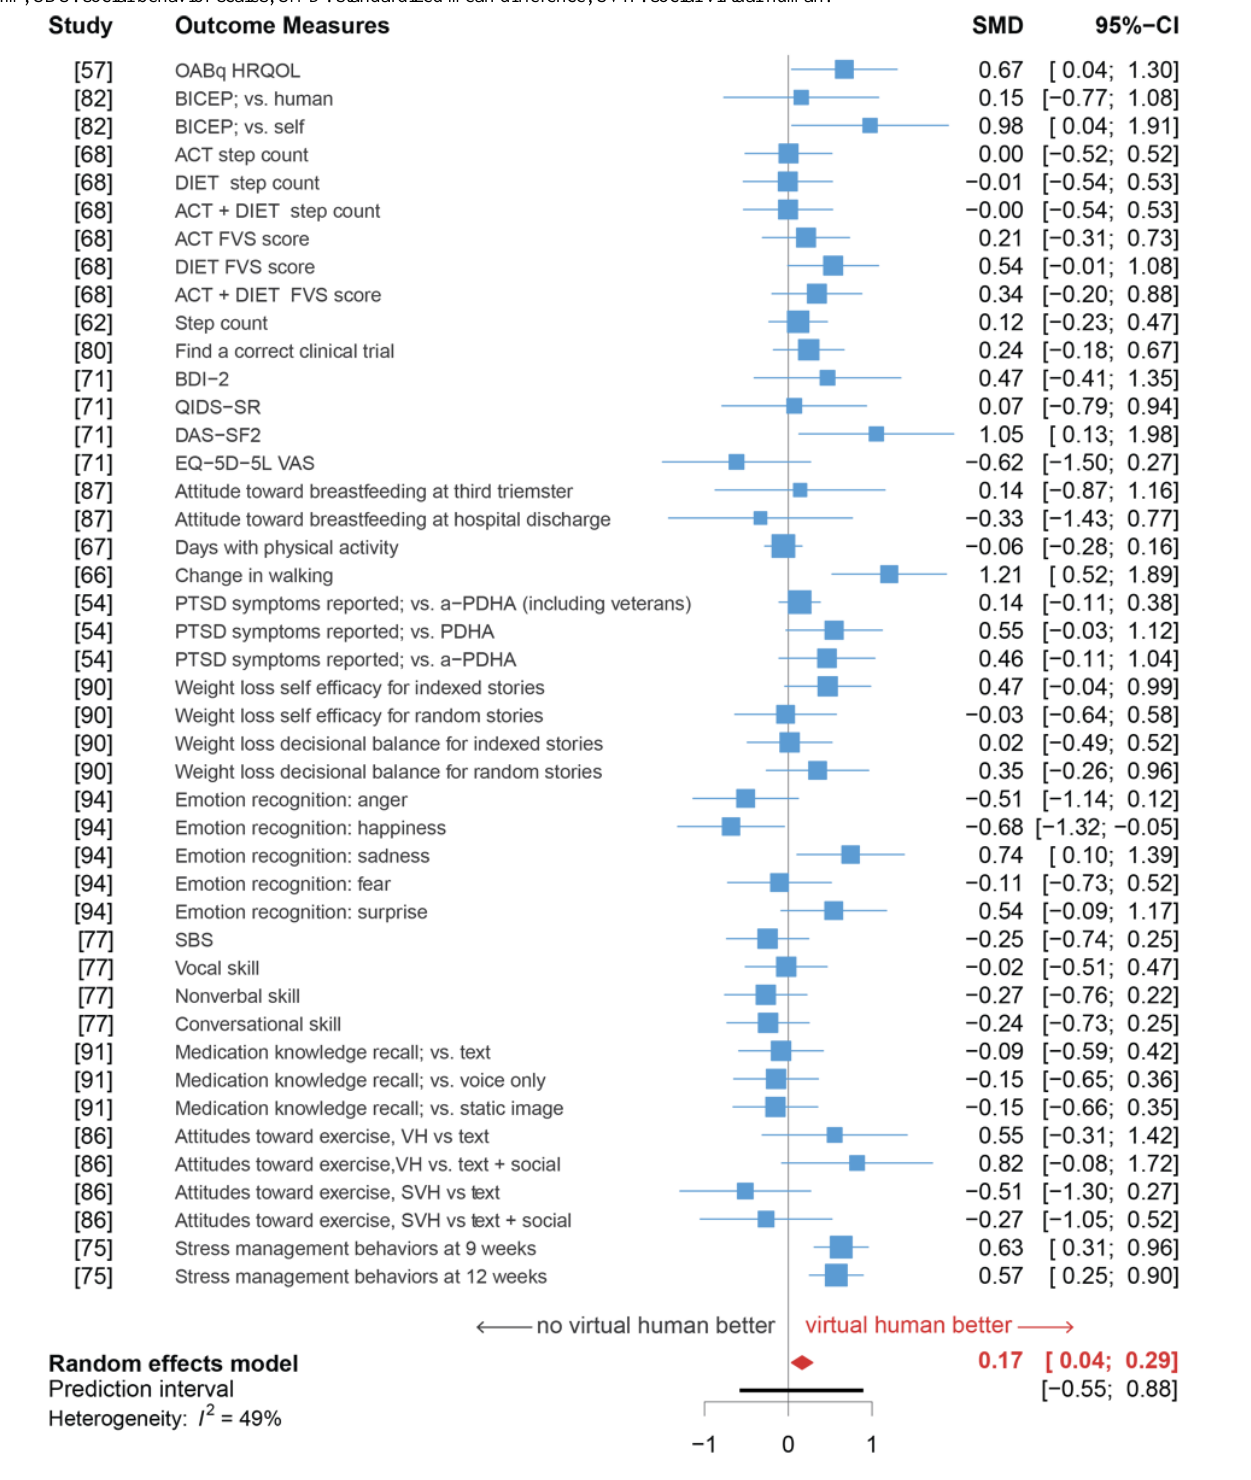
Figure 3. Forest plot of the meta-analysis of health-related virtual human interventions from 26 studies (44 primary outcomes). a-PDHA: anonymized post-deployment health assessment; ACT: physical activity; BDI-2: Beck Depression Inventory-II; BICEP: brief informed consent evaluation protocol; DAS−SF2: Dysfunctional Attitude Scale-Short Form 2; DIET: fruit and vegetable consumption; EQ−5D−5L VAS: 5-level version of the EuroQol 5D visual analogue scale; FVS: NIH/NCI Fruit and Vegetable Scan; HRQOL: health-related quality of life; OABq: overactive bladder questionnaire; PDHA: post-deployment health assessment; PTSD: post-traumatic stress disorder; QIDS−SR: Quality of Life Enjoyment and Satisfaction Questionnaire-Short Form; SBS: social behavior scales; SMD: standardized mean difference; SVH: social virtual